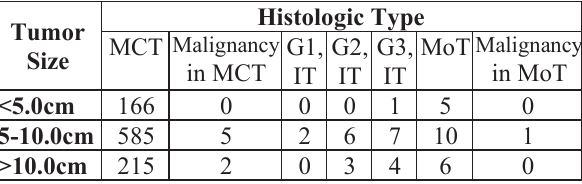
Table-2: Frequency of different histologic subtypes and